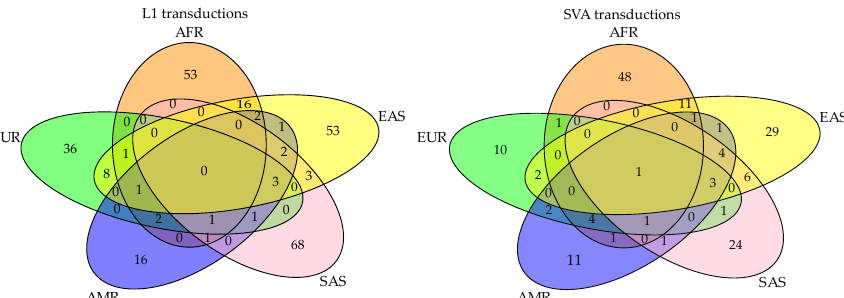
Figure 5. Venn diagram of high-confidence transduction loci across five super-populations. These plots represent the count and specificity of polymorphic transduction loci among the studied popula- tions. As shown here, the majority of these loci are super-population-specific.